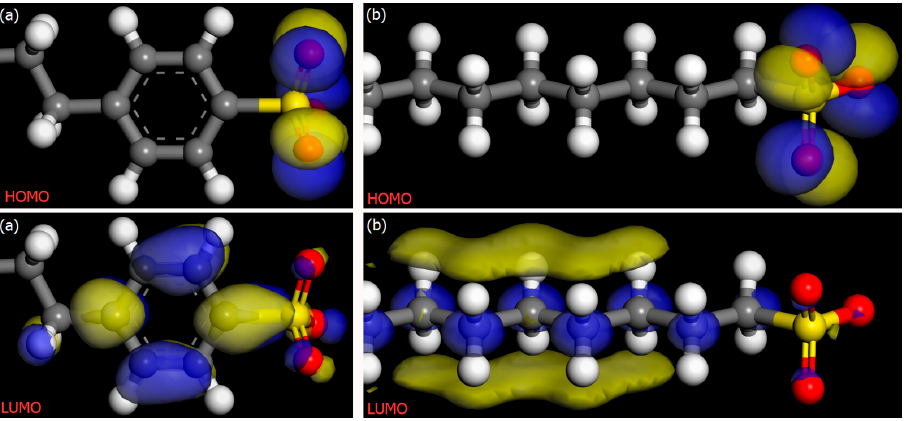
Figure 9. Isosurfaces of the frontier orbitals of ( a ) C12B and ( b ) C12 (Color codes: Red—O, Yellow—S, Gray—C, and White—H).